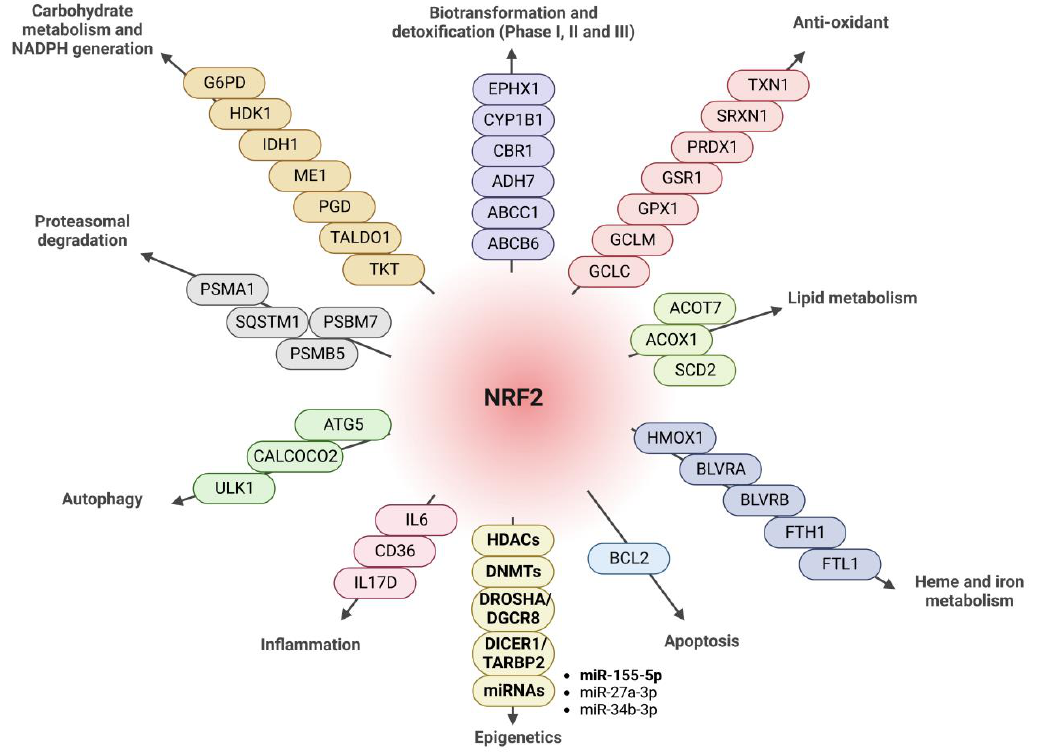
Figure 7. Diagram of the main targets of NRF2. NRF2 is implicated in the regulation of biotransformation and detoxification proteins (Phase I, II, III). ABCB6: ATP-binding cassette, subfamily B (MDR/Tap) member 6; ABCC1: ATP-binding cassette, subfamily C (CFTR/MRP); ADH7: alcohol dehydrogenase class 4 mu/sigma chain; CBR1: carbonyl reductase 1; CYP1B1: cytochrome